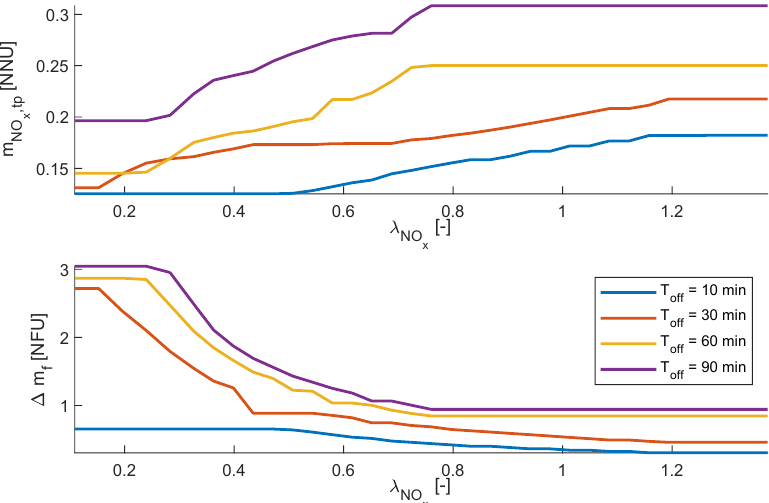
Figure 10. Results from simulations of the single-event cycle for different λ NO of 10, 30, 60, and 90 min. Note that all lines are flat for small and large λ NO are flat because pre-heating cannot be done with the specified equivalence factor. For small λ NO lines are flat because the maximum reduction in NO x is already achieved, and using more fuel does not improve the